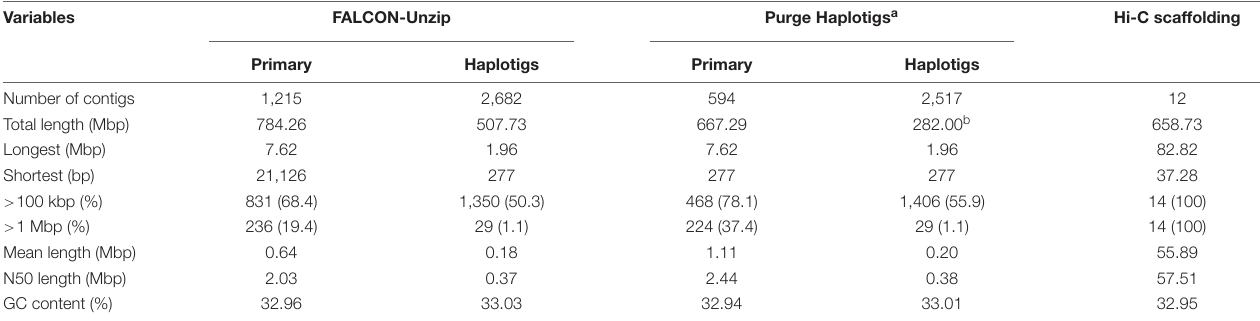
TABLE 1 | Summary statistics of the V. paradoxa accession ‘KA01’ genome assembly, by stage.